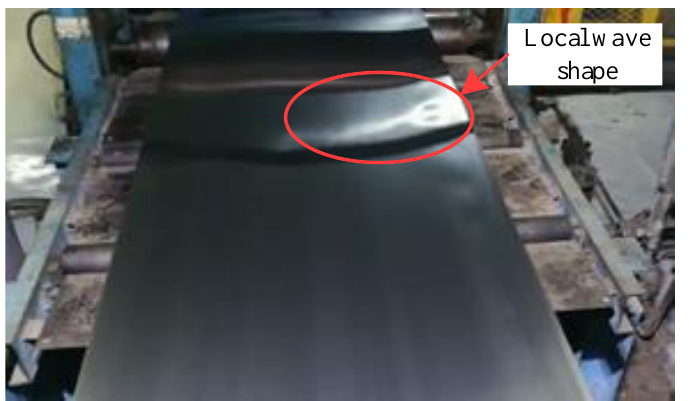
Figure 3. Diagram of the flatness data reading results.